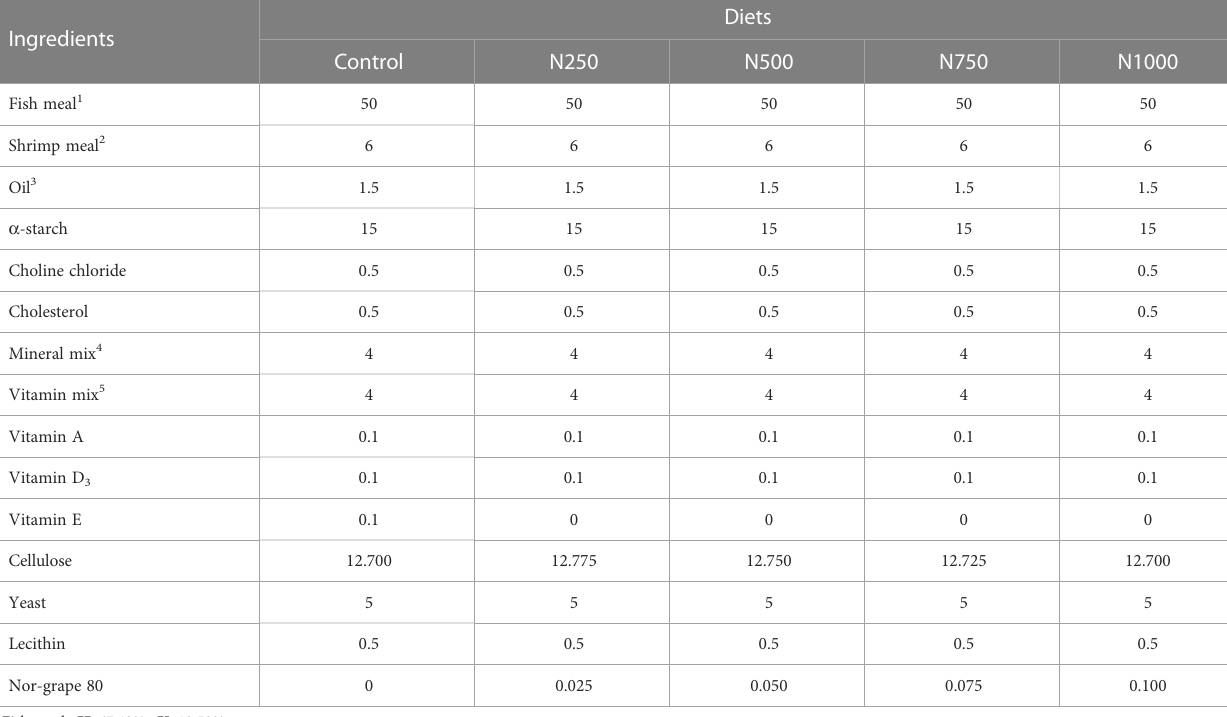
TABLE 1 Ingredient composition of dietary treatments for white shrimp.